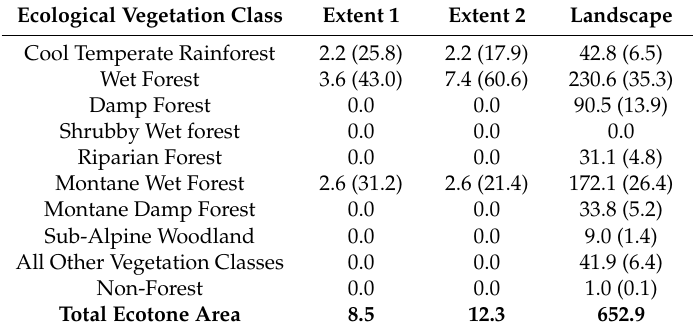
A visual comparison of the PEM model and the EVC distributions in each 5 km × 5 km extent (see Figure 1 for locations) indicated good general agreement for rainforest and eucalypt forest areas (Figure 7). In general, the finer-scale resolution of the PEM model differentiated stand type patches in contrast to the more continuous distributions of the EVC map. A network of rainforest patches, evident in the bottom left of the first PEM subset, was absent from the EVC map. In contrast, rainforest in the second subset was patchy and covered less area than the cool temperate rainforest EVC.